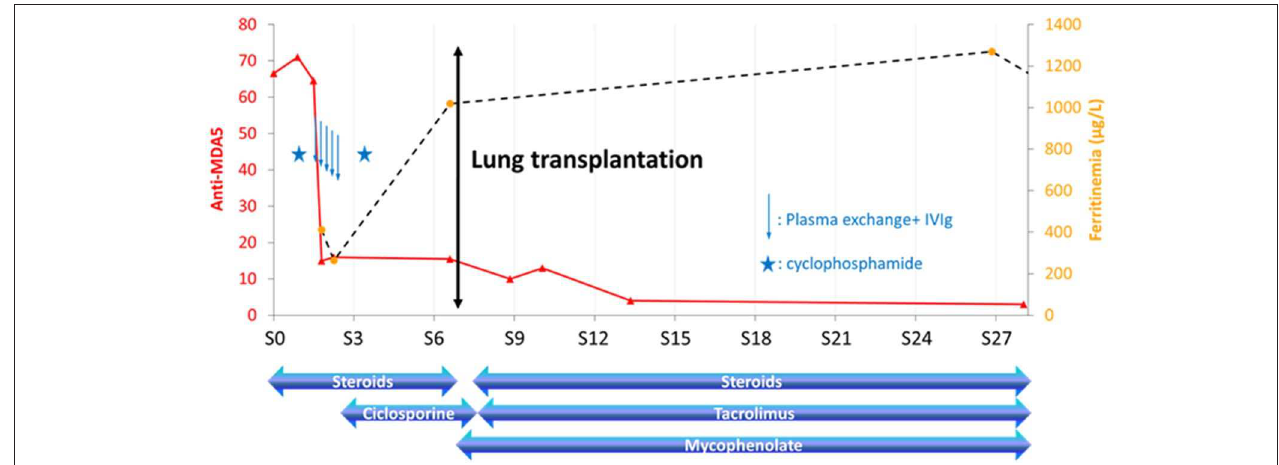
FIGURE 3 | Biological follow-up and treatment of Case #2. The full curve represents the regression of anti-MDA5 antibodies titers (expressed as relative intensity) and the dotted curve the evolution of serum ferritin level. Five plasma exchanges were performed (arrows), preceded and followed by cyclophosphamide infusions (depicted with stars). MDA5, melanoma differentiation–associated gene